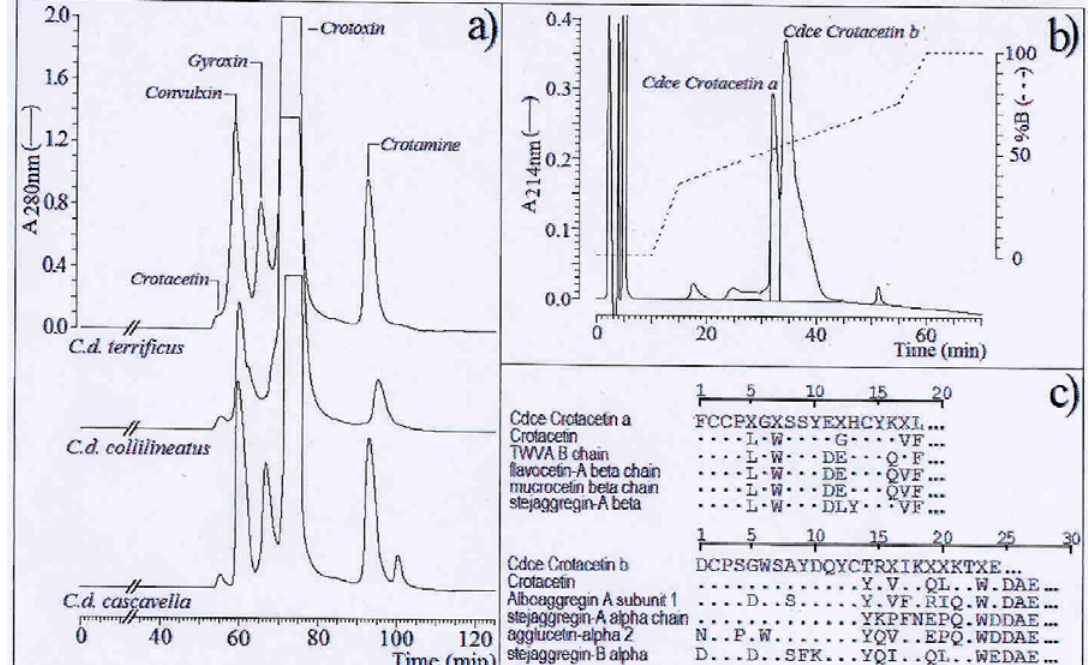
Figure 3: Isolation, reduction and determination of N-terminal sequence of crotacetin from C. durissus